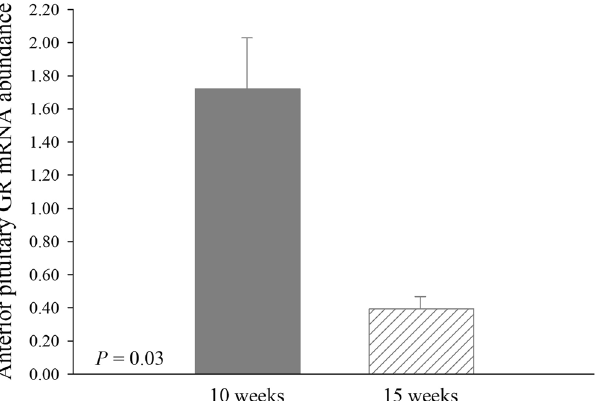
Figure 3. Effects of age [10 weeks ( n = 24 pigs) and 15 weeks ( n = 24 pigs)] on the mRNA abundance of glucocorticoid receptor (GR) in the anterior pituitary of pigs. Data are presented as LSmeans ±